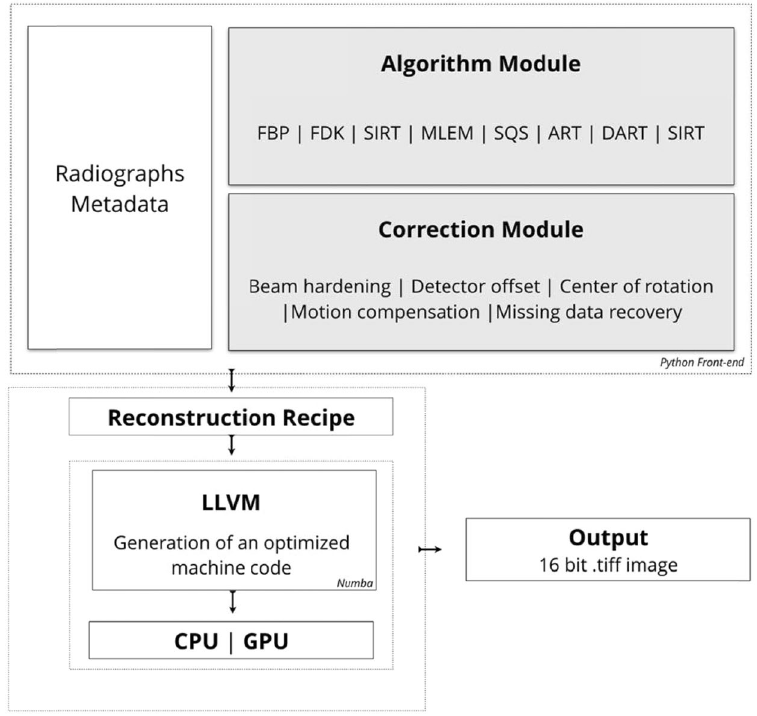
Figure 8. The framework of the software package. The package consists of different modules of algorithms and correction tools which eventually allows users to test several options without compromising the